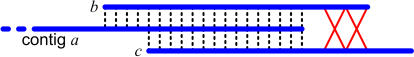
Overlap ambiguity detection.Contig a overlaps with contigs b and c to the right, but b and c do not fully overlap each other, indicating a region of ambiguity such as a repeat boundary or misassembly.